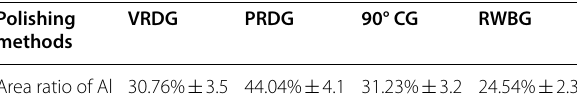
Table 2 Area ratio of aluminum on the copper side Polishing VRDG PRDG 90° CG methods